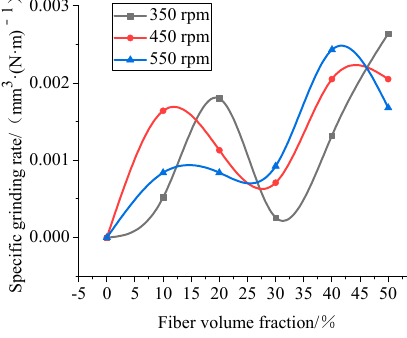
Figure 15. E ff ect of the volume fraction on the wear rate of type 2 composites. Figure 15. Effect of the volume fraction on the wear rate of type 2 composites.